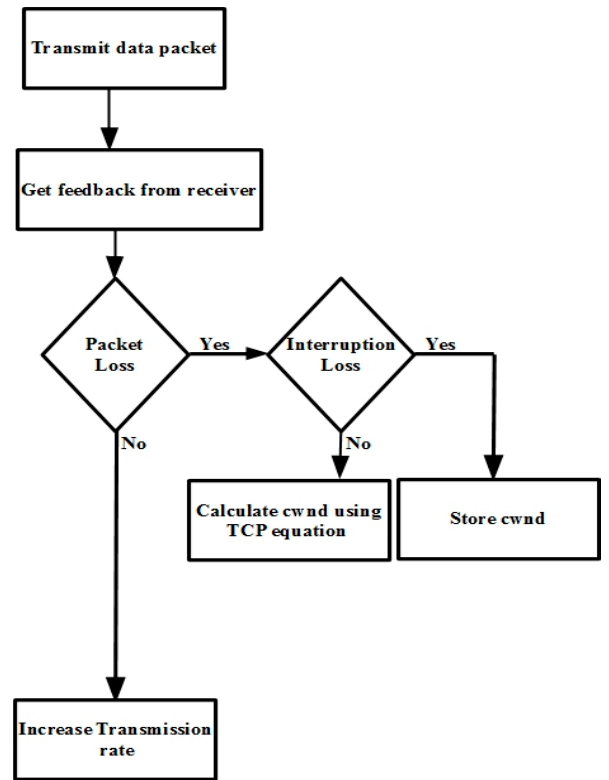
Figure 5. OHTP congestion control mechanism.